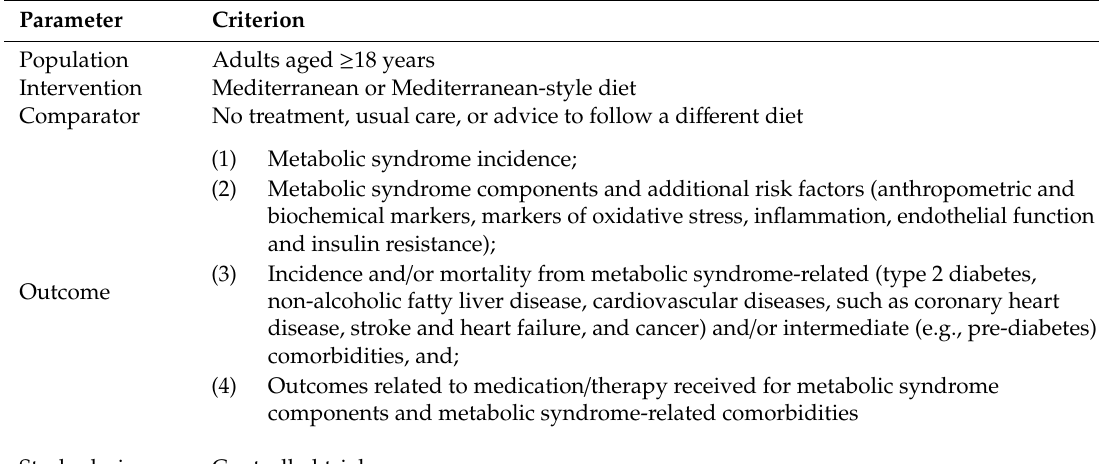
Table 1. Criteria for inclusion of